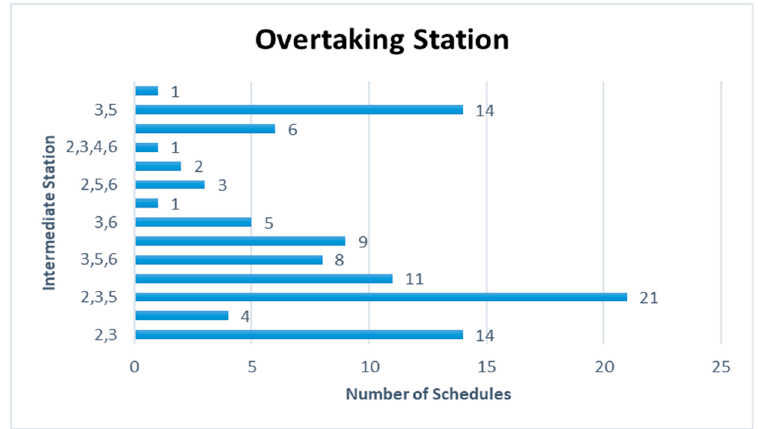
Figure 24. Overtaking Station for Case 6.